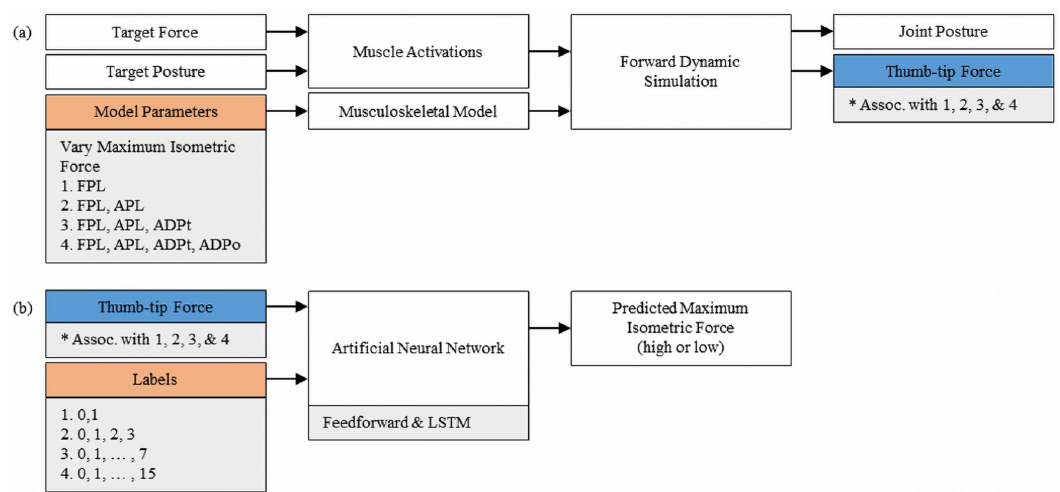
Fig 2. Simulation and machine learning workflow. (a) Workflow for producing simulated lateral pinch data. Muscle activations were attained via computed muscle control. (b) Workflow for training and testing artificial neural networks on simulated thumb-tip forces and